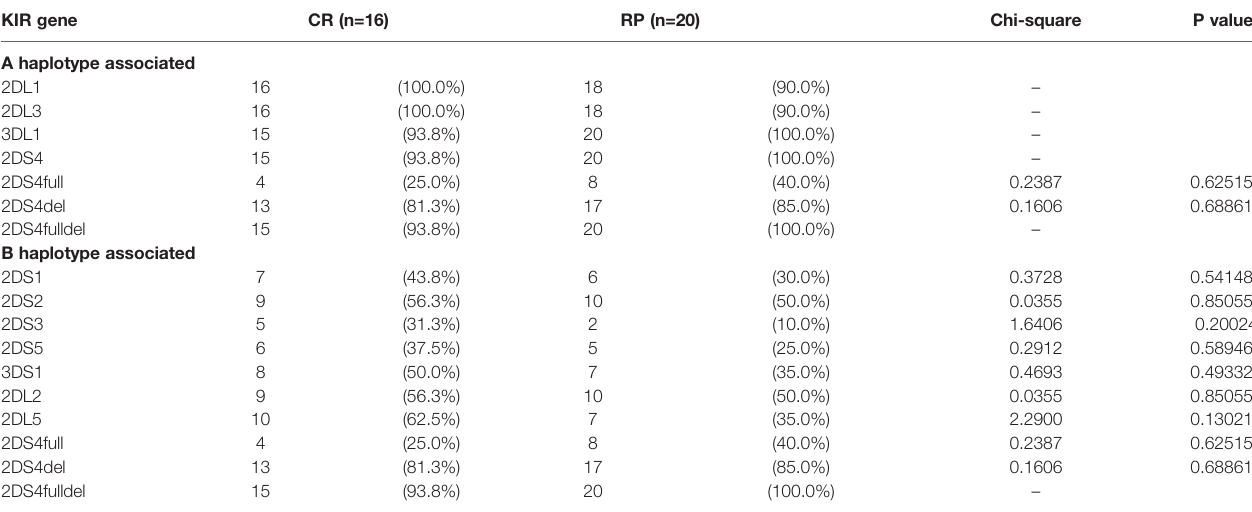
TABLE 2 | Comparison of the frequencies of KIR genes in NC treatment